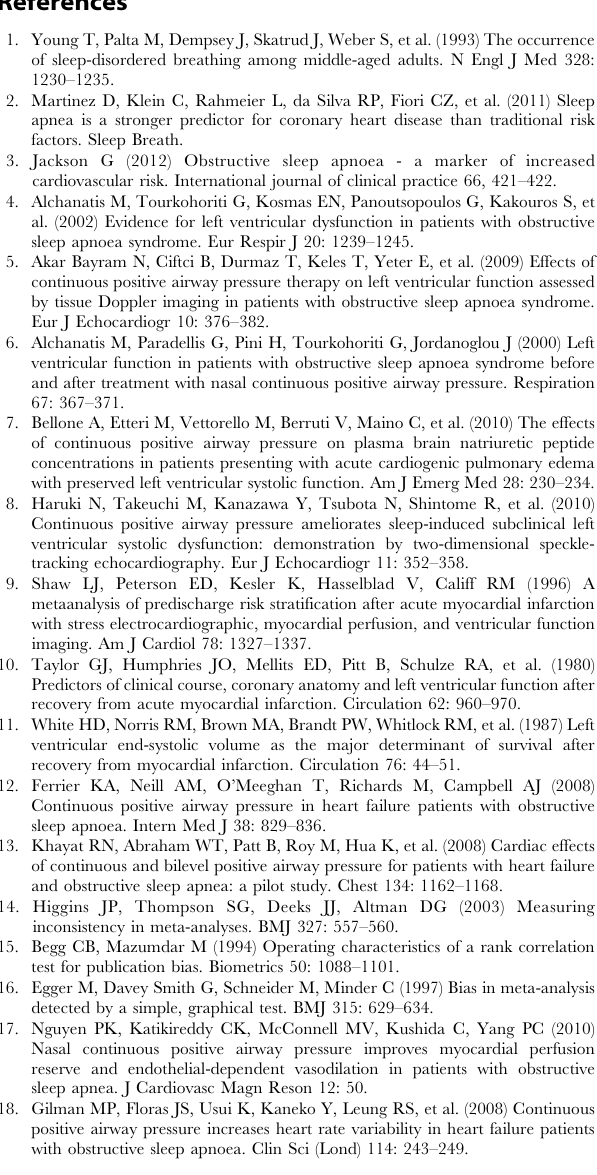
Figure S5 Sensitivity analysis of selected studies. CI: confidence